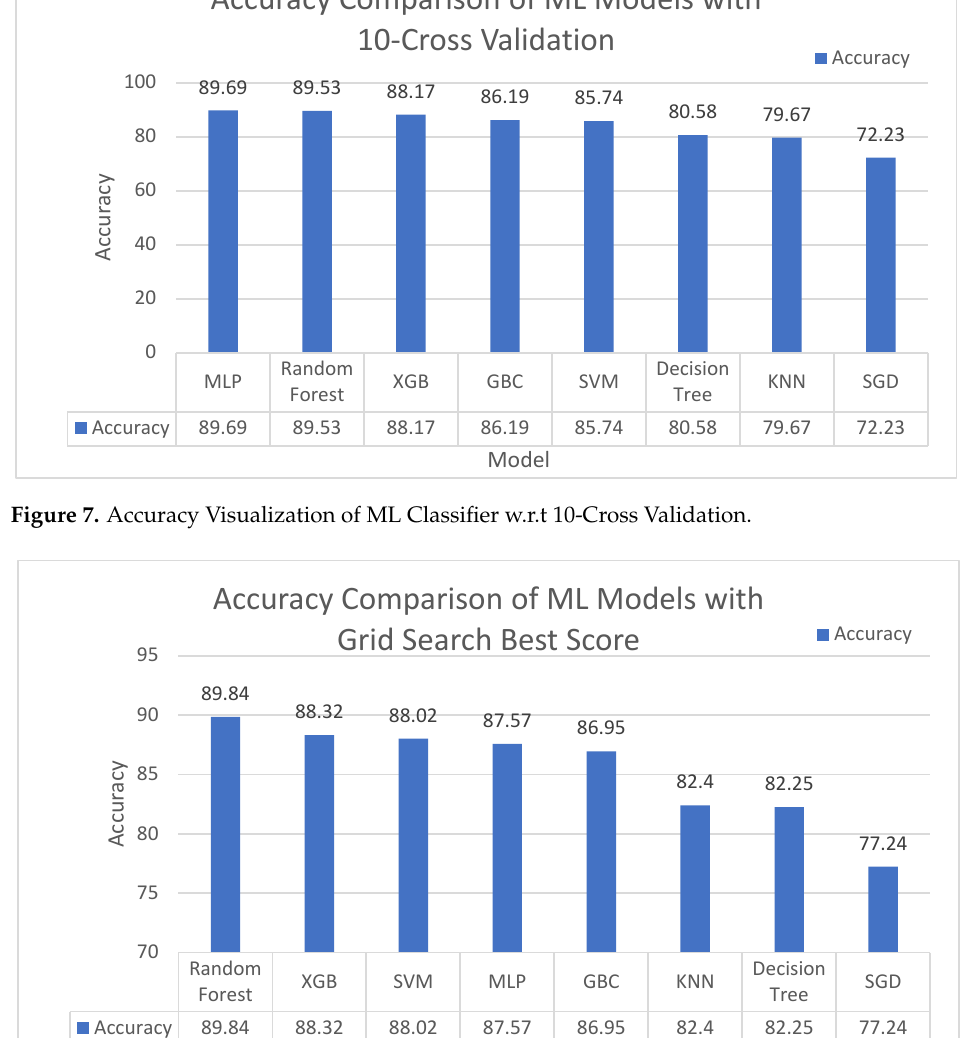
Figure 8. Accuracy Visualization of ML Classifier w.r.t Grid Search Best Score.